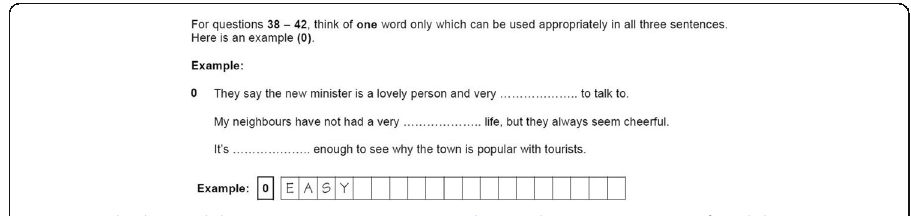
Fig. 5 Cambridge English Language Assessment ’ s (2010b) sample item in CAE Use of